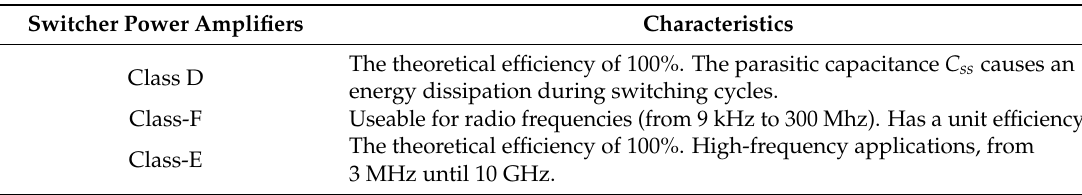
Table 4. Switched power